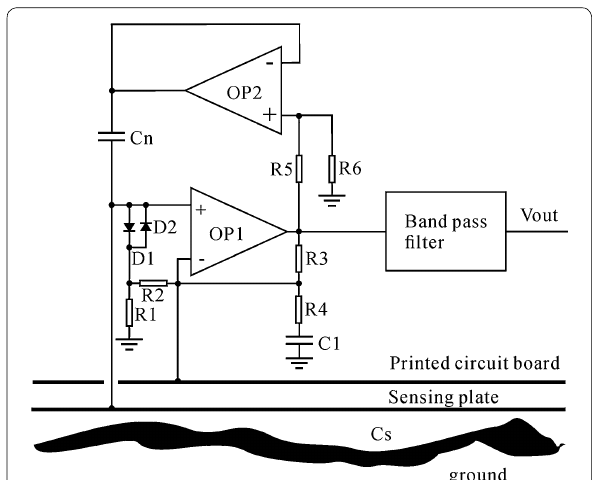
Fig. 3 Diagram of the capacitive electrode. The electrode consists of an analog amplifier and a standard printed circuit board. The sensing plate (diameter 15 cm), along with the analog amplifier OP1, forms the high-impedance front end with a capacitance neutralization circuit. The plate capacitor C s is formed by the ground and the plate of the electrode connected to the non-inverting input of OP1. Diodes D 1 and D 2 provide a resistive path at the amplifier input without essentially shorting the signal to the amplifier. The gain of the first stage is simply set by R 1 and R 2 . A well-known active shield is used to avoid current leakage at the input. The voltage divider formed by C s and C in has a detrimental effect on the gain and channel matching. To address this,